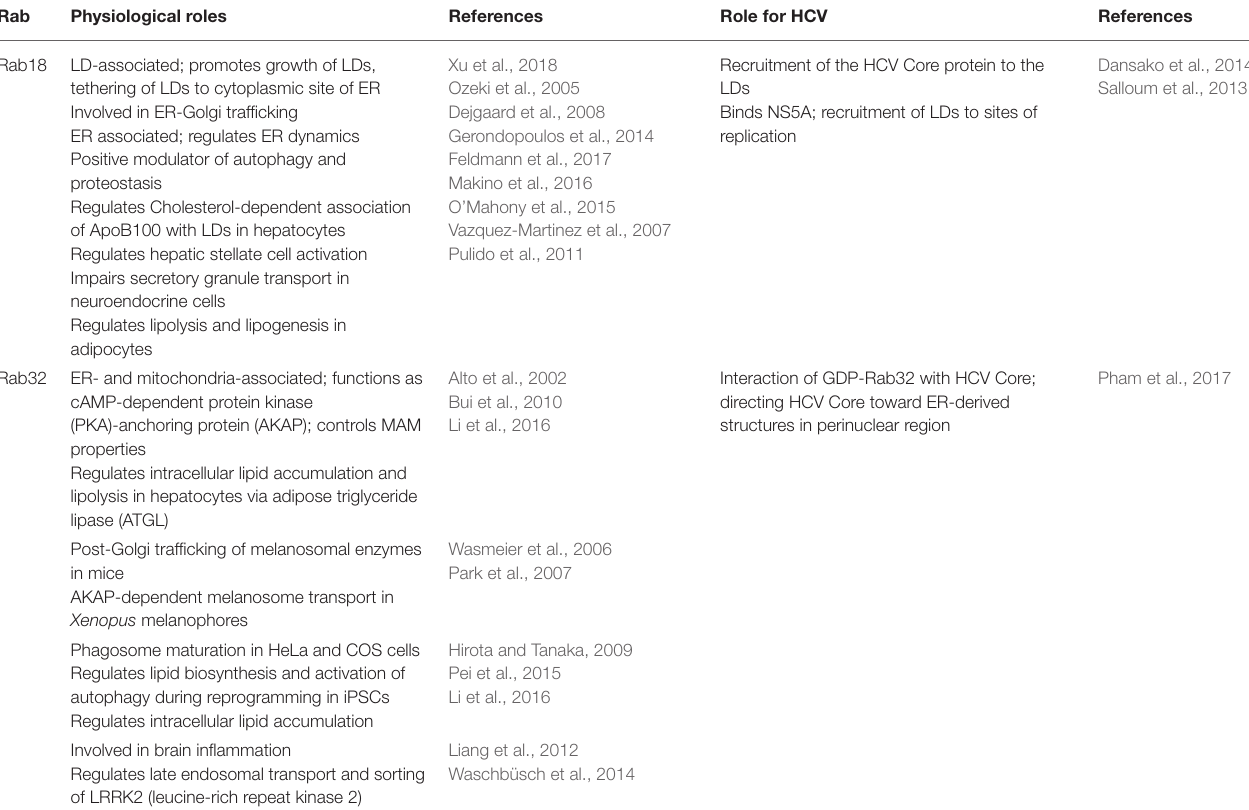
TABLE 3 | Rab proteins involved in HCV